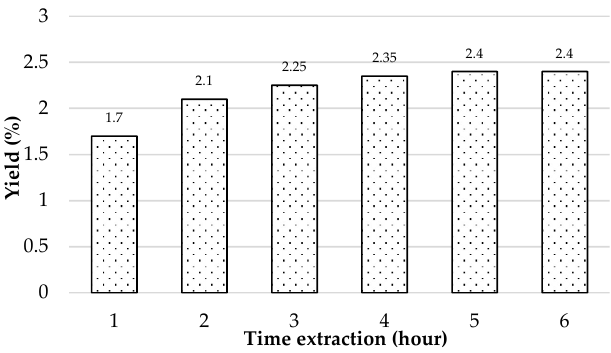
Figure 8. The influence of temperature extraction on the yield of essential oil.